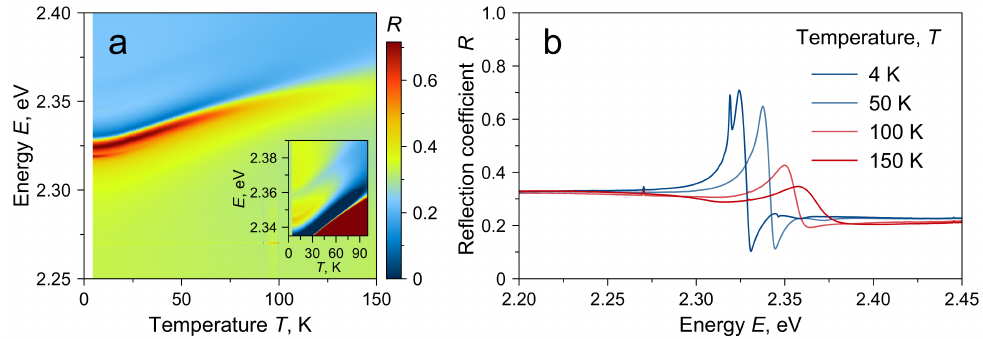
Figure 2. ( a ) Reflectivity spectra in normal geometry for different temperatures. The inset shows a magnified region with excited excitonic states. ( b ) Reflectivity spectra in normal geometry for different sample